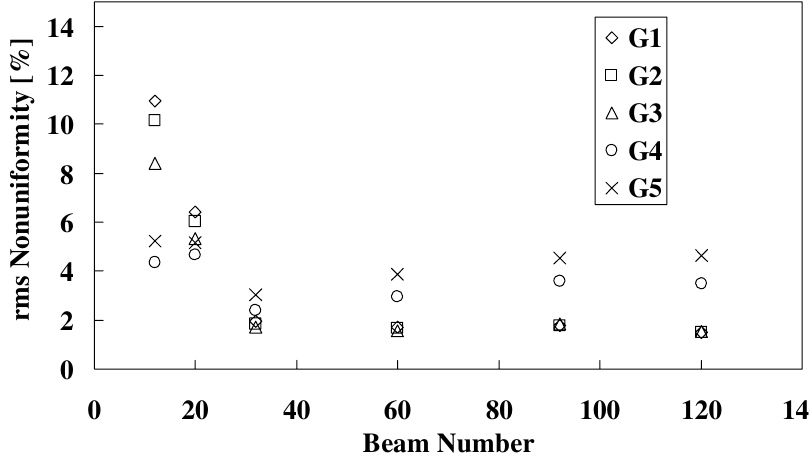
FIG. 13. The rms nonuniformity versus HIB total number in the case of the Al layer target with the chamber radius of 5 m including the longitudinal beam temperature of 100 MeV and the transverse beam radial emittance of 5.0 mm mrad using five Gaussian types.